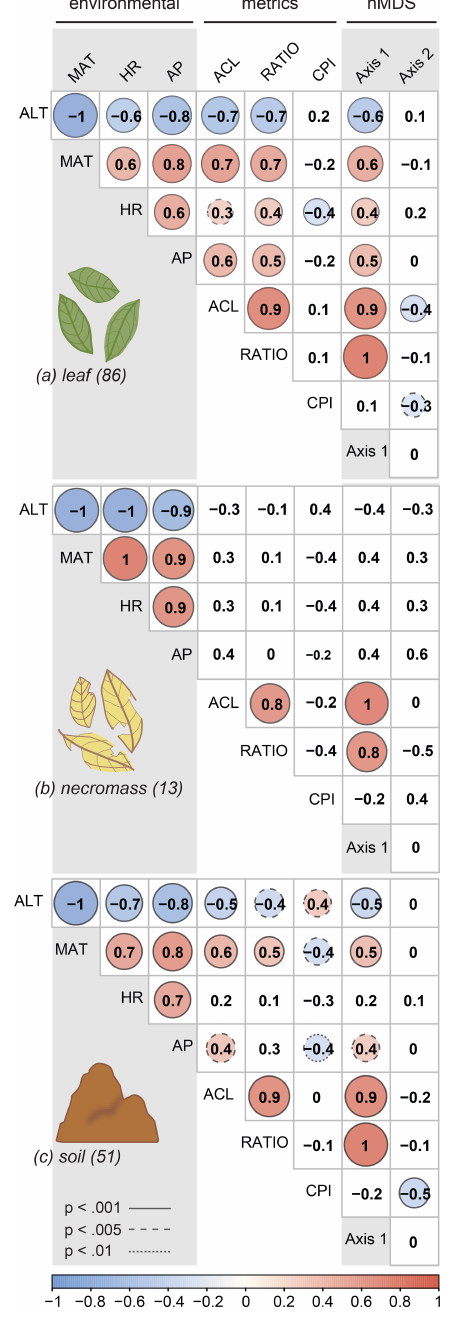
Figure 4. Pearson’s correlation coefficient matrix per sample type (a, b, c) showing the correlations between environmen- tal variables (ALT = altitude, MAT = temperature, HR = humidity, AP = precipitation), n -alkane metrics (ACL = average chain length, RATIO = ratio C 31 / (C 31 + C 29 ), CPI = carbon preference index), and the nMDS axes (Axis 1, Axis 2). Numbers in parentheses represent number of samples. Significant correlations are circled, where the colour and circle size indicate the direction and corre- lation strength. Circle outlines reflect the significance level. Non- significant correlations are not